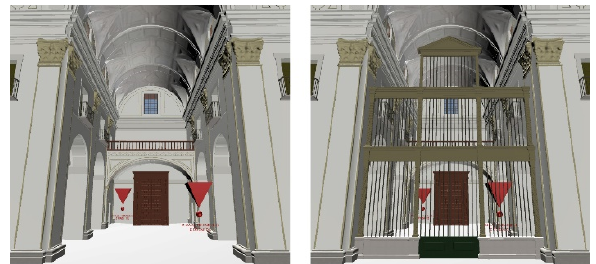
Figure 10: Activation and deactivation of the decorative components of the vaults through the context menu of the Model scene